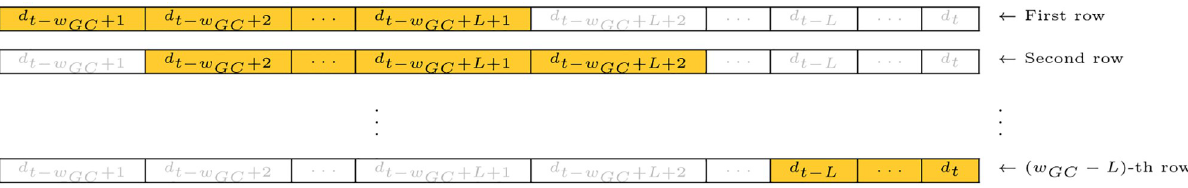
Fig 4. The data included when performing a Granger-causality test on day t , where w GC = 40 and L = 1, 2, 3, 4, 5. d t represents the data available on day t